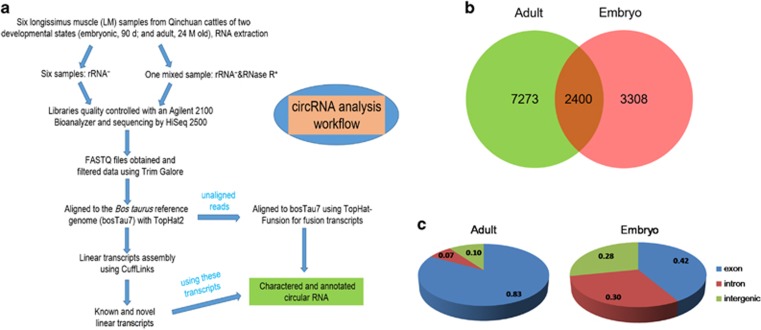
Identification of circular RNAs in bovine skeletal muscle tissue. (a) Workflow for the preparation and analysis of circRNA libraries, (b) Venn diagram depicting different circRNAs uncovered at two developmental stages (embryonic and adult tissues), and (c) origin of circRNAs described in this study in the bovine genome